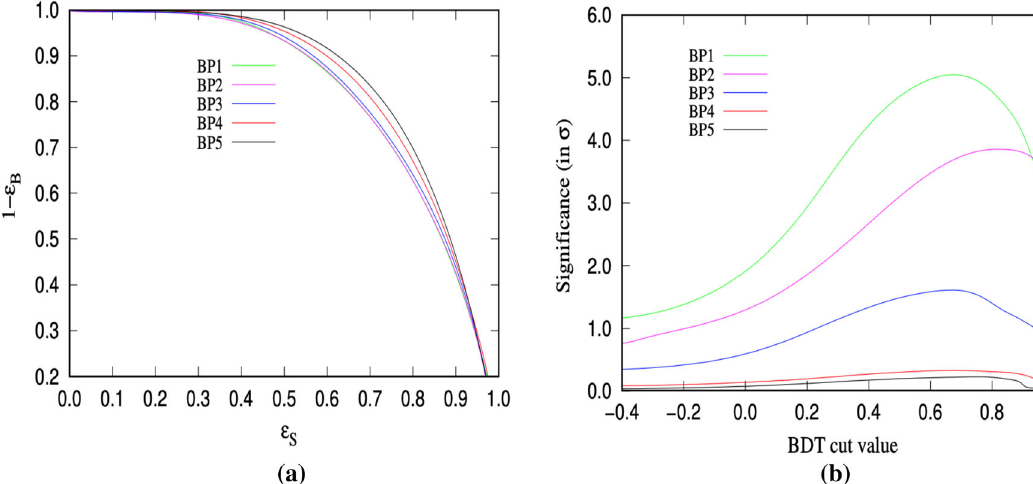
Fig. 6 a ROC curves for chosen benchmark points for 1 (cid:3) + E T / channel. b Variation of significance with BDT-score for 1 (cid:3) + E T /